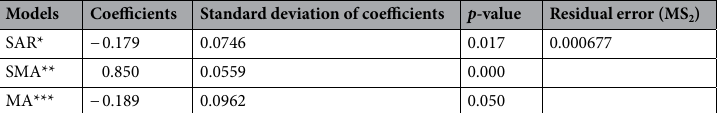
Table 8. The statistical analysis of the SARIMA ( 0,1,1 ) × ( 1,1,1 ) model. *SAR model implies the